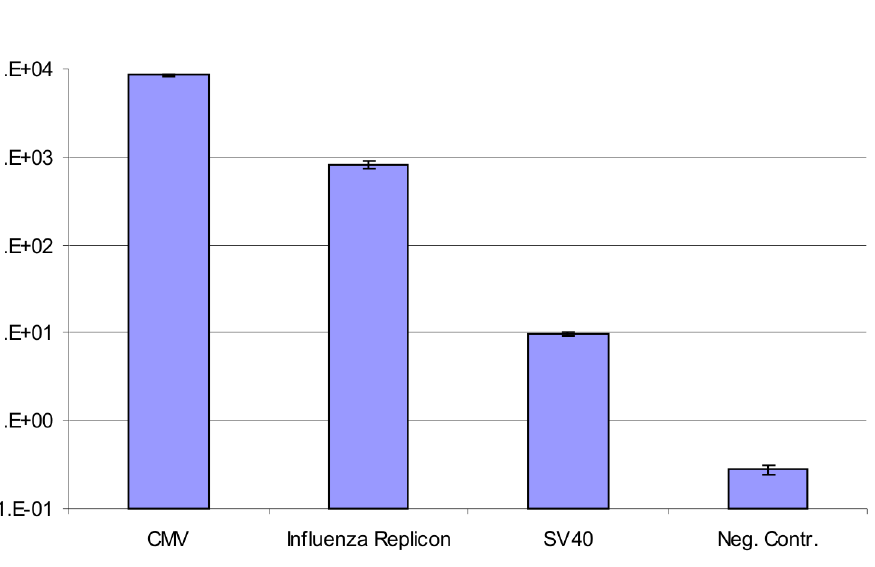
Figure 7. Comparison of firefly luciferase expression driven by CMV, SV40 or by the influenza replicon. HEK-293 cells were either tranfected with pcDNA-luc (CMV), pGL3-control (SV40) or with the influenza replicon and pMono-lucNS (Influenza Replicon) or with pMono-lucNS and pBi-NP only (Neg. Contr.). Additionally, pRL, coding for Renilla luciferase, was cotransfected in all cases. Cells were harvested 48 hours post transfection and subjected to luciferase assay. Firefly values have been normalized to Renilla values. Data represents arithmetic mean values and standard deviation.